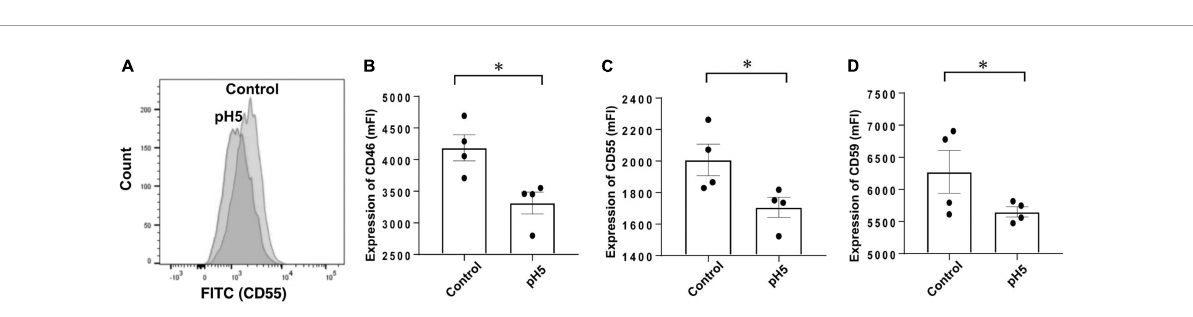
FIGURE7 Expression of membrane complement regulators (CRegs) of Met-5A cells stimulated with acidic condition medium. (A) Shows a sample of histograms of expression for CD55 stimulated with pH 5.0-adjusted culture medium and control neutral medium (pH 7.4). (B–D) Show that stimulation with pH 5.0 acid medium decreased expression of CRegs on the cell surface of Met-5A. ∗ P <